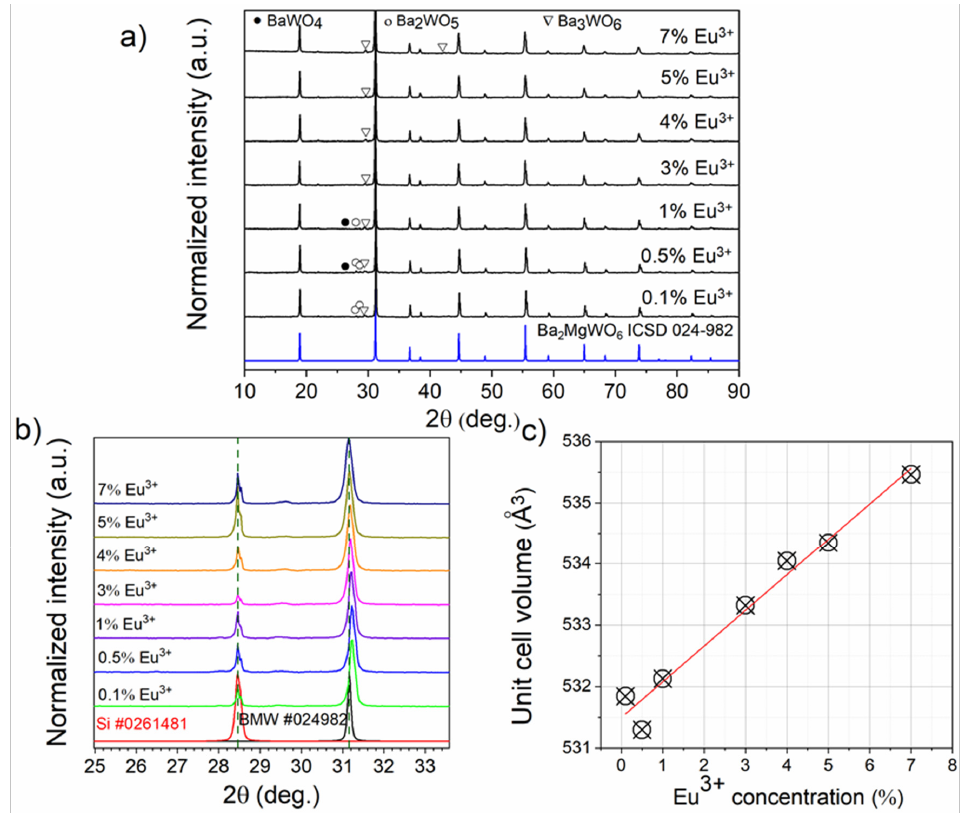
Figure 2. ( a ) The X-ray powder di ff raction of Ba 2 MgWO 6 : x% Eu 3 + , (x = 0.1, 0.5, 1, 3, 4, 5, 7 %) ( b ) Figure 2. a ) The X-ray powder diffraction of Ba 2 MgWO 6 : x% Eu 3+ , (x = 0.1, 0.5, 1, 3, 4, 5, 7 %) b ) the the shifting of position of di ff raction lines with Eu 3 + concentration and ( c ) The changing of unit cell shifting of position of diffraction lines with Eu 3+ concentration and c ) The changing of unit cell volume volume as a function of Eu 3 + concentration.